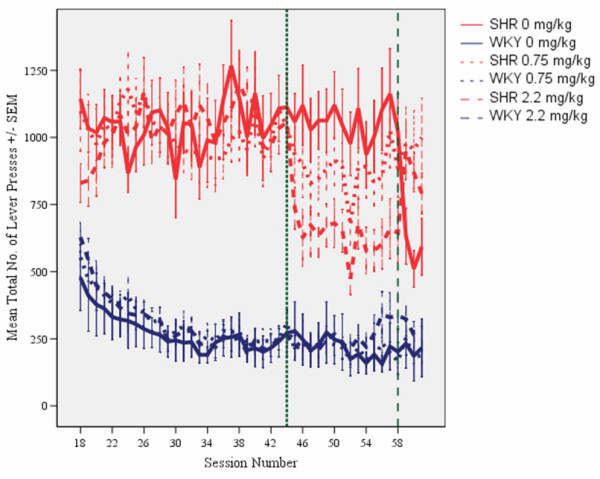
Effects of l-amphetamine on total number of lever presses (correct plus incorrect) by SHR and WKY controls. Means ± SEM. Sessions 31 through 44 served as baseline sessions. Treatment was given at sessions 45 through 58. Sessions 59 through 61 were used for studying post-treatment effects, except for the groups that received vehicle (saline, 0 mg/kg) during treatment sessions 45-58. These groups received 2.2 mg/kg l-amphetamine to check for typical responsiveness to the drug for SHR and WKY.